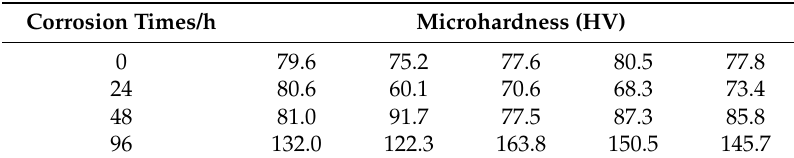
Table 3. Microhardness of coatings on different corrosion time.